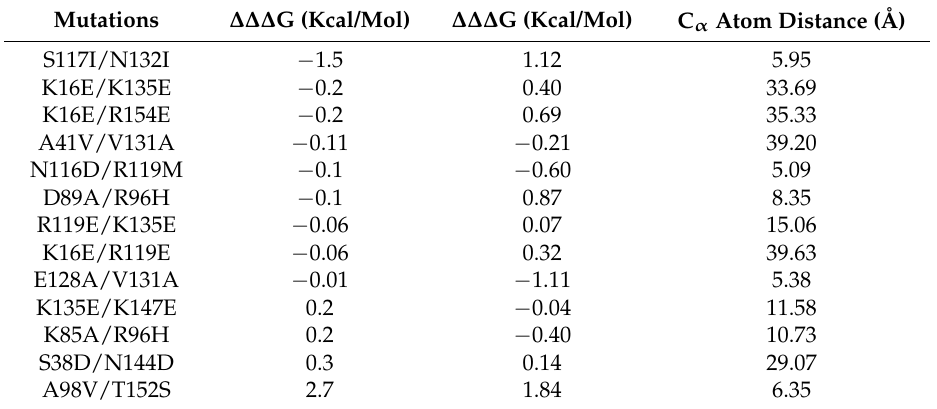
Table 4. The free energy changes of 13 double mutations in T4 phage lysozyme by MAESTROweb. Mutations ∆∆∆ G (Kcal/Mol) ∆∆∆ G (Kcal/Mol) C α Atom Distance (Å) S117I/N132I − 1.5 1.12 5.95 K16E/K135E − 0.2 0.40 33.69 K16E/R154E − 0.2 0.69 − 0.11